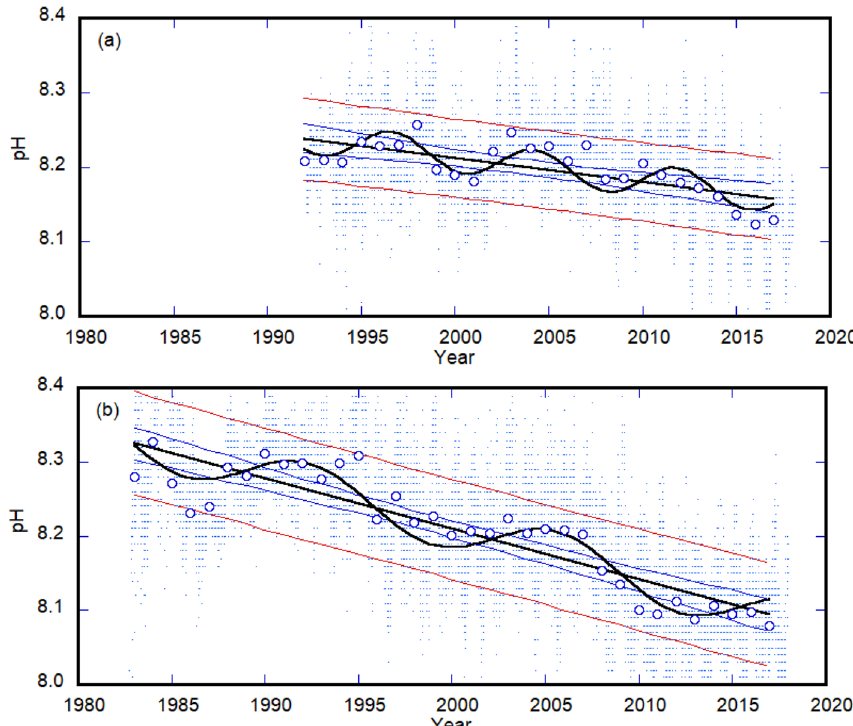
Figure 2. Long-term trends in the oceanic pH in the coastal regions of the Sea of Japan and North Pacific. The Demonstration Laboratory (DL) on the coast of the Sea of Japan (a) and Central Laboratory (CL) on the coast of the Pacific Ocean (b) . Background dots indicate data. Blue circles show the annual averages. Black straight lines show linear trends while sine curves show decadal oscillations. Blue and red straight lines show the 95% confidence level and prediction intervals of the predicted values, respectively. Table 1 summarizes the trend slopes, acidification rates, statistical p -values, and correlation coefficients.